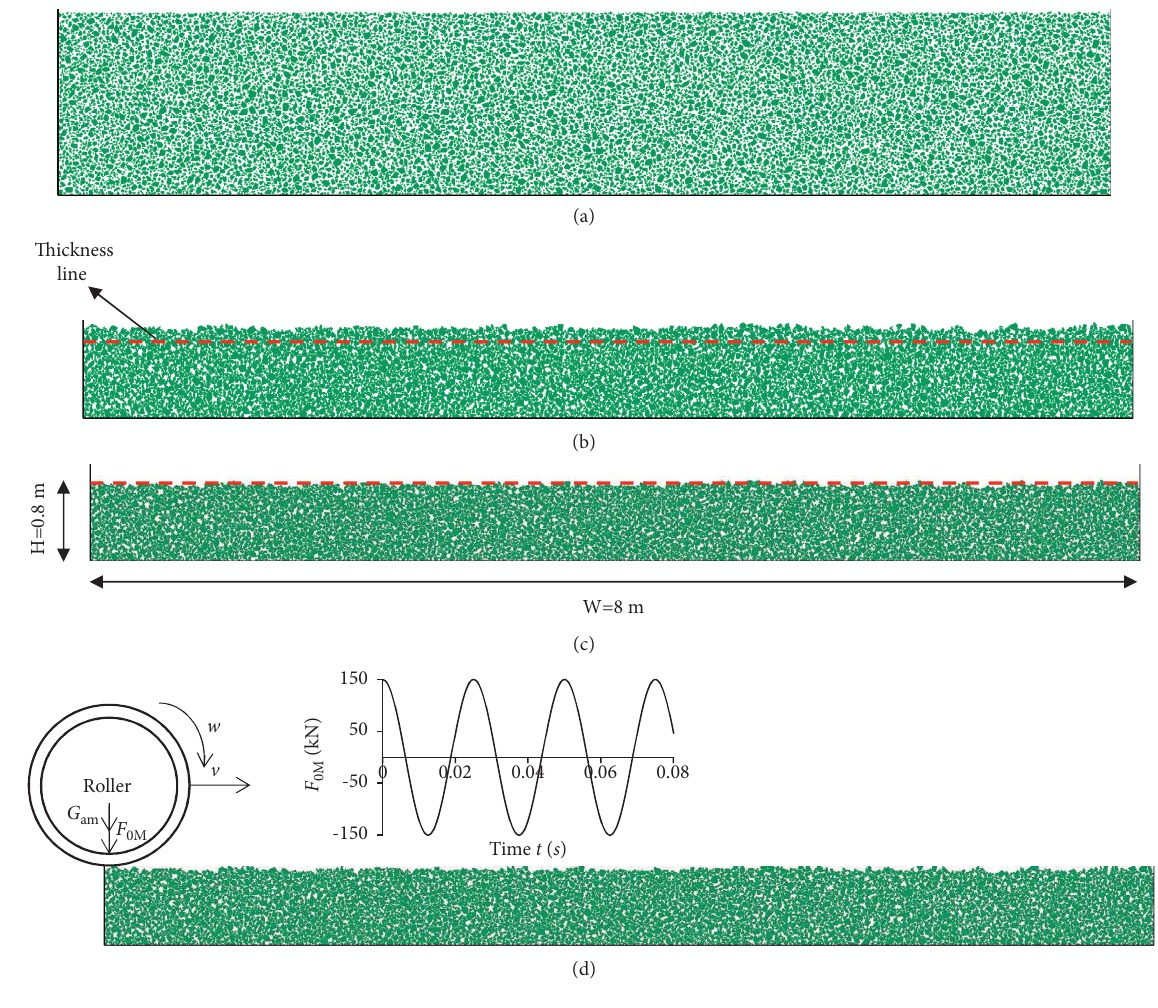
Figure 15: PFC simulation of vibratory compaction, including dumping, spreading, and compaction. (a) The contactless model; (b) sedimentation accumulation; (c) leveling; (d) vibratory compaction. Table 3: External load